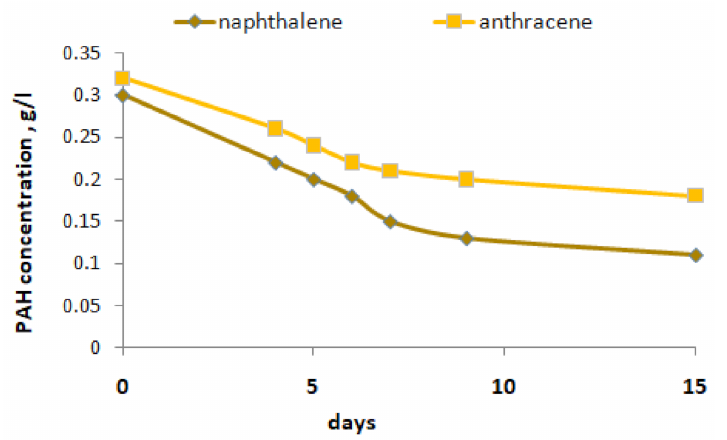
Figure 2. Degradation of naphthalene and anthracene in the Czapek Dox mineral medium by the Aspergillus glaucus strain AL1 for 15 days at 23 ◦ C. Table 2. Mass balance after growth of Aspergillus glaucus AL1 on single LMW PAH.